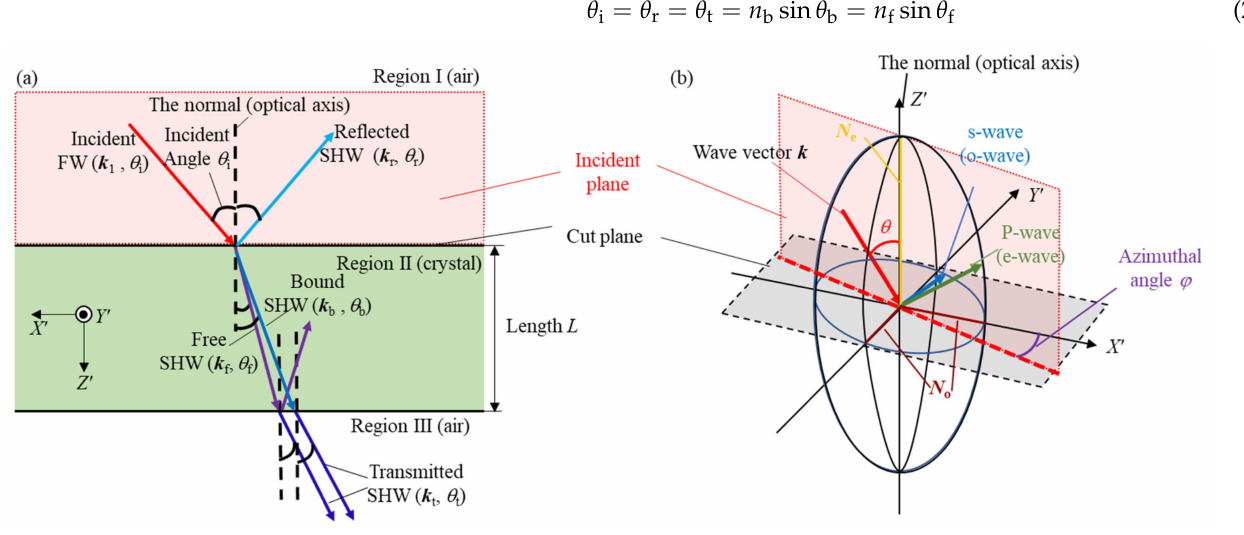
Figure 4. ( a ) The propagation model in the incident plane; ( b ) the refractive index